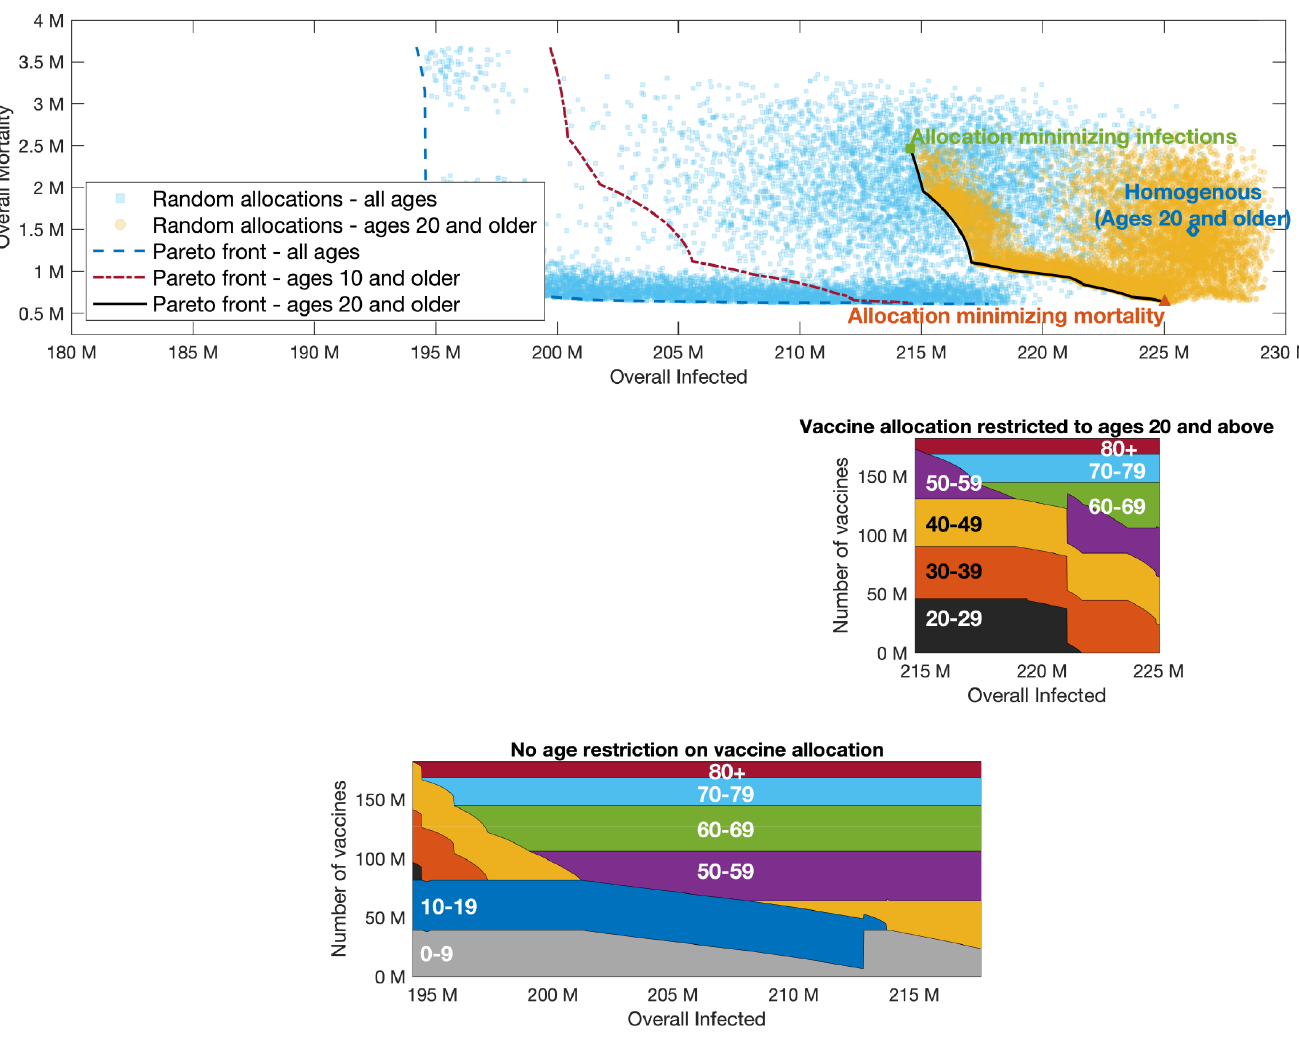
Fig 7. Pareto front. Same as Fig 5 with R 0 =